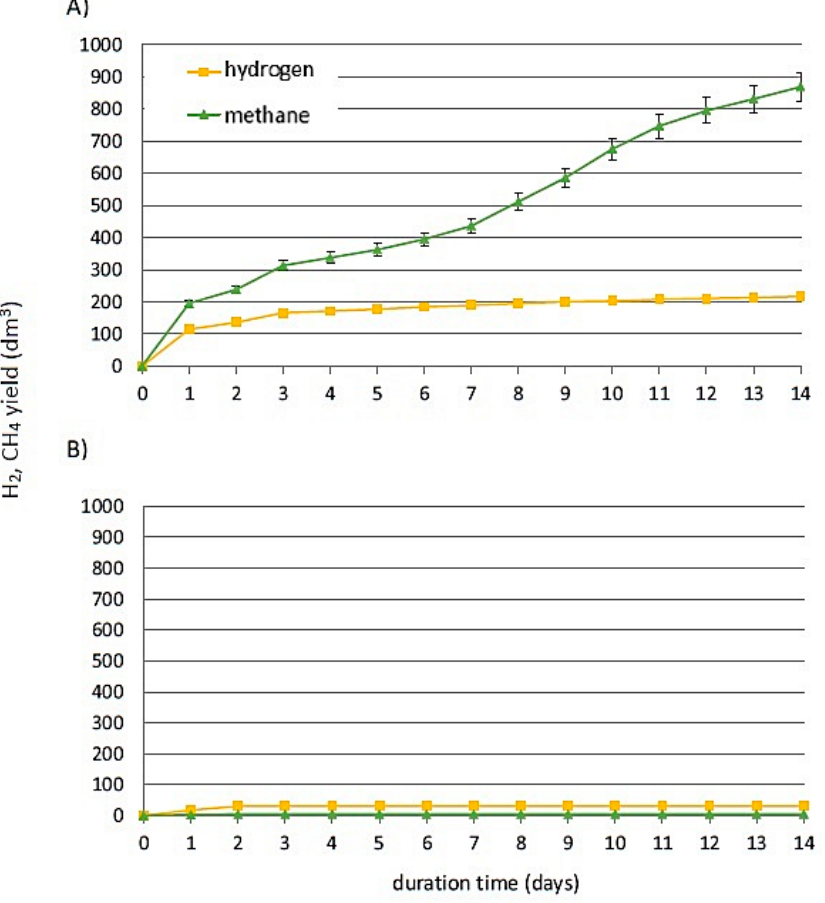
Figure 2. Cumulative hydrogen and methane productions for TSBP-1without pretreatment ( A ) and with pH adjustment followed by thermal pretreatment ( B ).